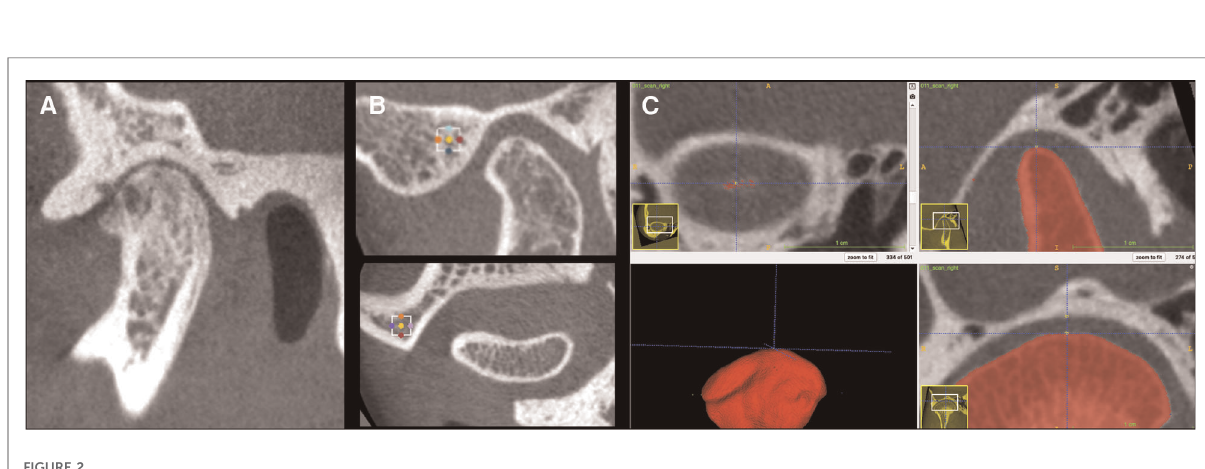
( Figure 2B ) with 30 × 30 × 30 slices. The posterior regions of the articular fossa were not included due to the presence of